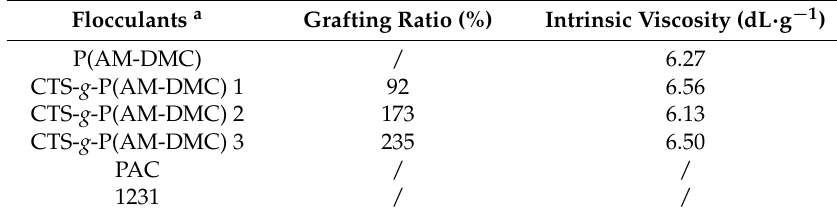
Table 1. The details of the flocculants used for the flocculation